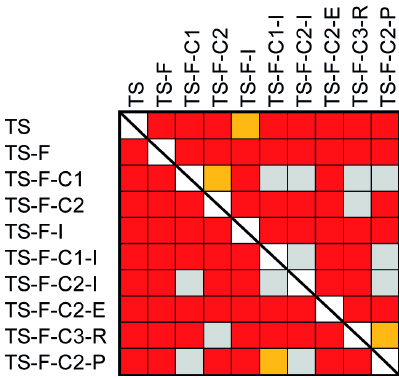
Figure 6. Statistical comparison among classifications using the McNemar (lower-left triangle) and overall accuracy (upper-right triangle) significance tests. Grey cells indicate no significant difference, orange indicates significant differences p < 5% and red significant differences p < 1% using a two-tailed z-test.